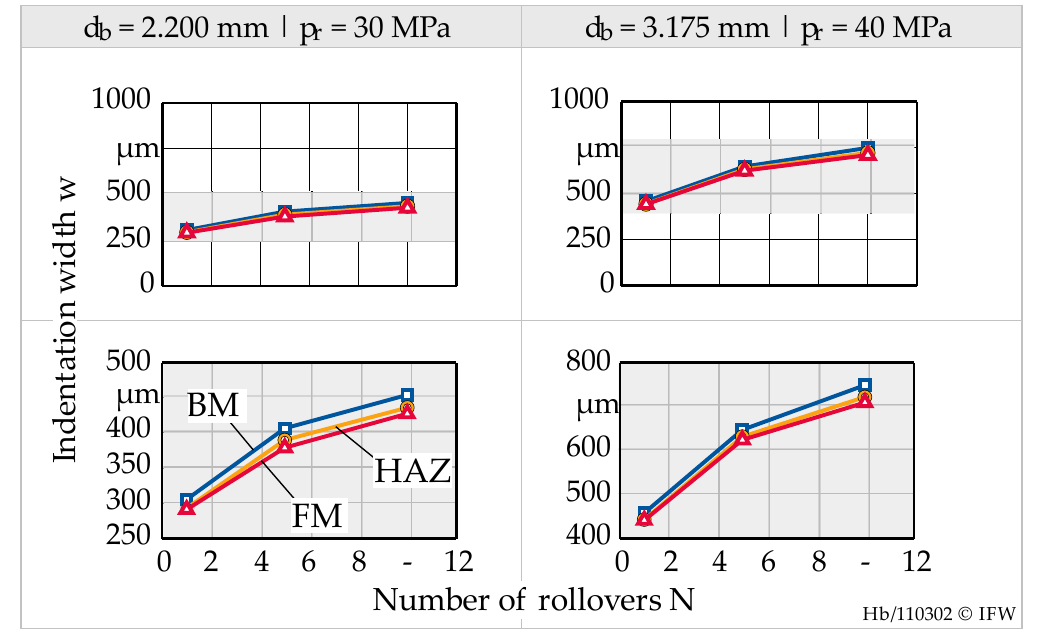
Figure 6. Evaluation of experimentally determined track widths for two parameter combinations .